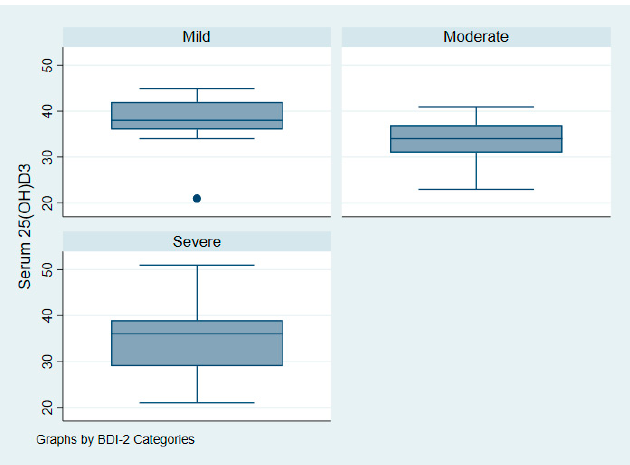
Figure 4. Serum vitamin D 25(OH)D of patients with depression according to symptoms severity.